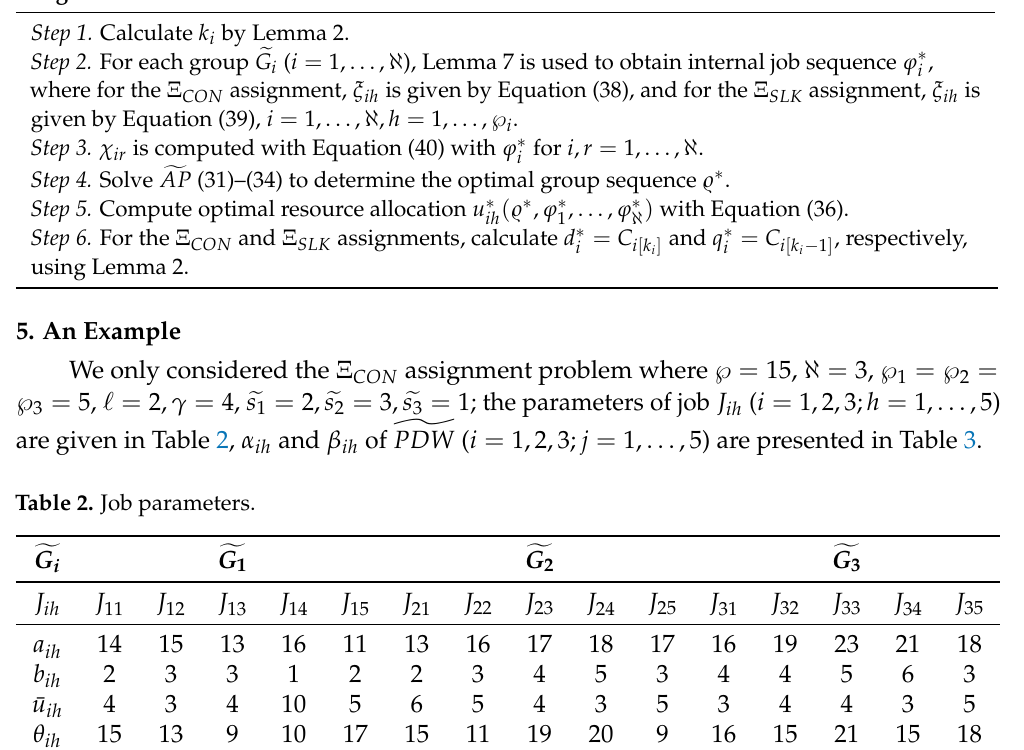
Algorithm 2: Convex resource